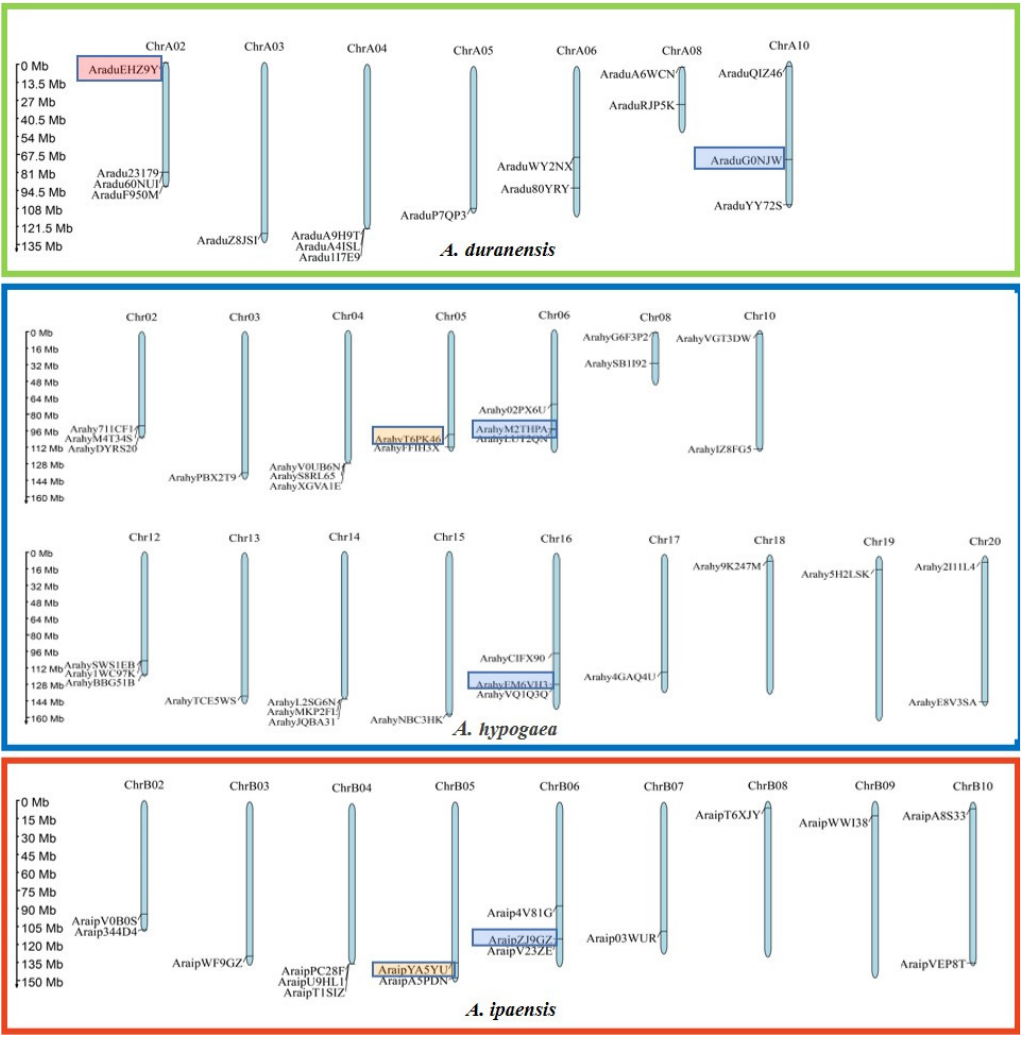
Figure 3. Chromosomal distribution of PEBP genes in peanut genome and its two ancestors. The green, red and blue rectangles represent the three Arachis genomes of two diploid A. ipaensis, A. duranensis and the tetraploid A. hypogaea , respectively. The blue bars represent the chromosomes, and the PEBP genes were marked on different chromosomes. Red frame means that gene is absent in the corresponding position of cultivated peanuts. Yellow frames mean that genes have undergone homologous recombination between the A and B subgenomes. Blue frames mean that genes have transposed in wild peanuts